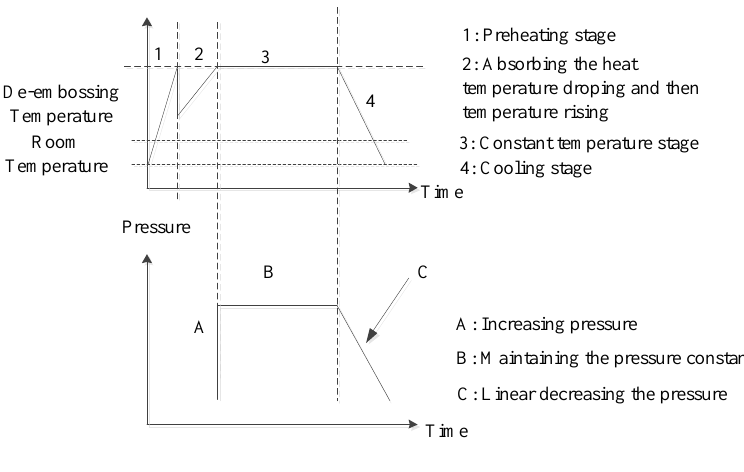
Figure 3. The pressure-temperature profile for hot